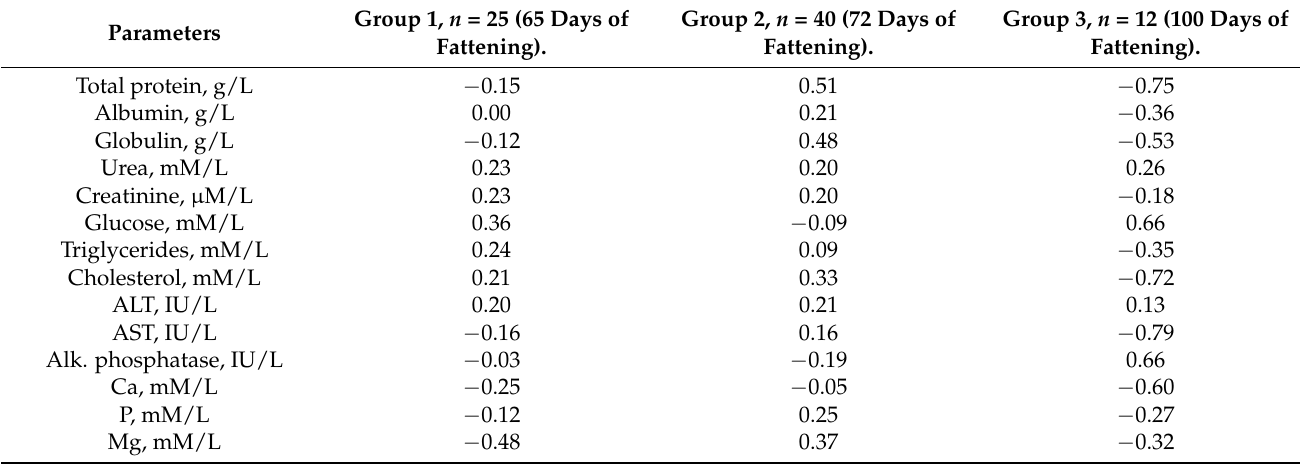
Table 4. Correlations of antioxidant parameters (TAWSA) with biochemical parameters of the blood serum of the Duroc breed pigs in groups 1, 2 and 3 (65, 72 and 100 days of fattening, respectively). Group 1, n = 25 (65 Days of Group 2, n = 40 (72 Days of Group 3, n = 12 (100 Days of Parameters Fattening). Fattening). Fattening). Total protein, g/L − 0.15